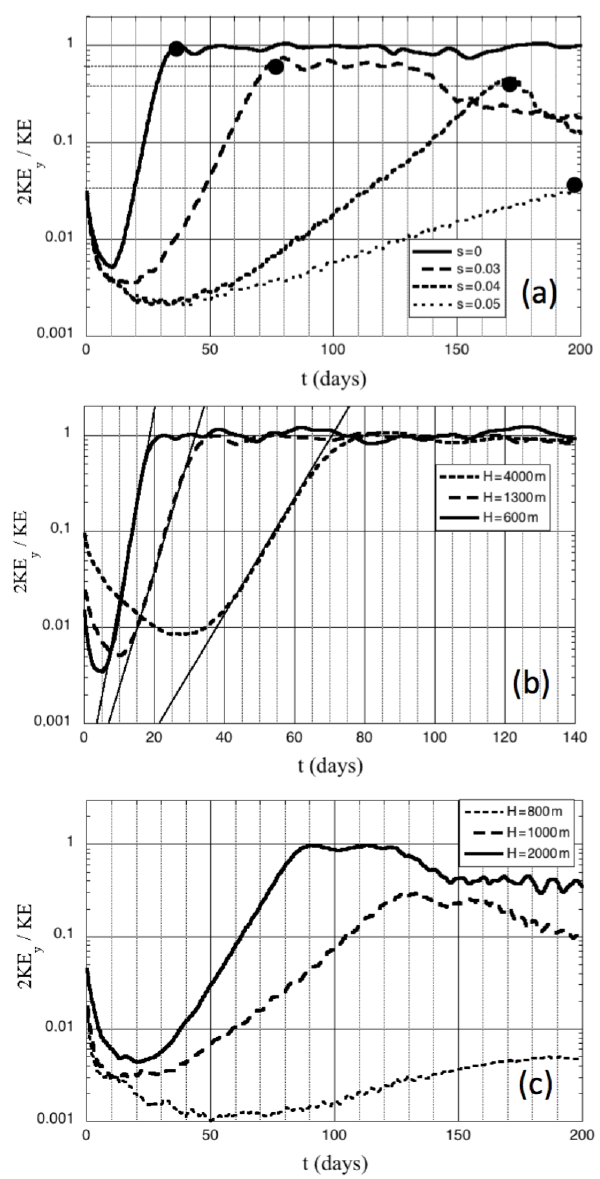
Figure 2. Time evolution of R(t) = 2KE y / KE. In the upper panel (a) the depth H = 1300 m is kept constant while the shelf slope varies: s = 0 , 3 , 4 , 5%. The central panel (b) corresponds to the flat bottom configuration ( s = 0) for various depth H = 600, 1300, 4000m. In the bottom panel (c) the shelf slope s = 3% is kept con- stant while the depth varies: H = 800, 1000,